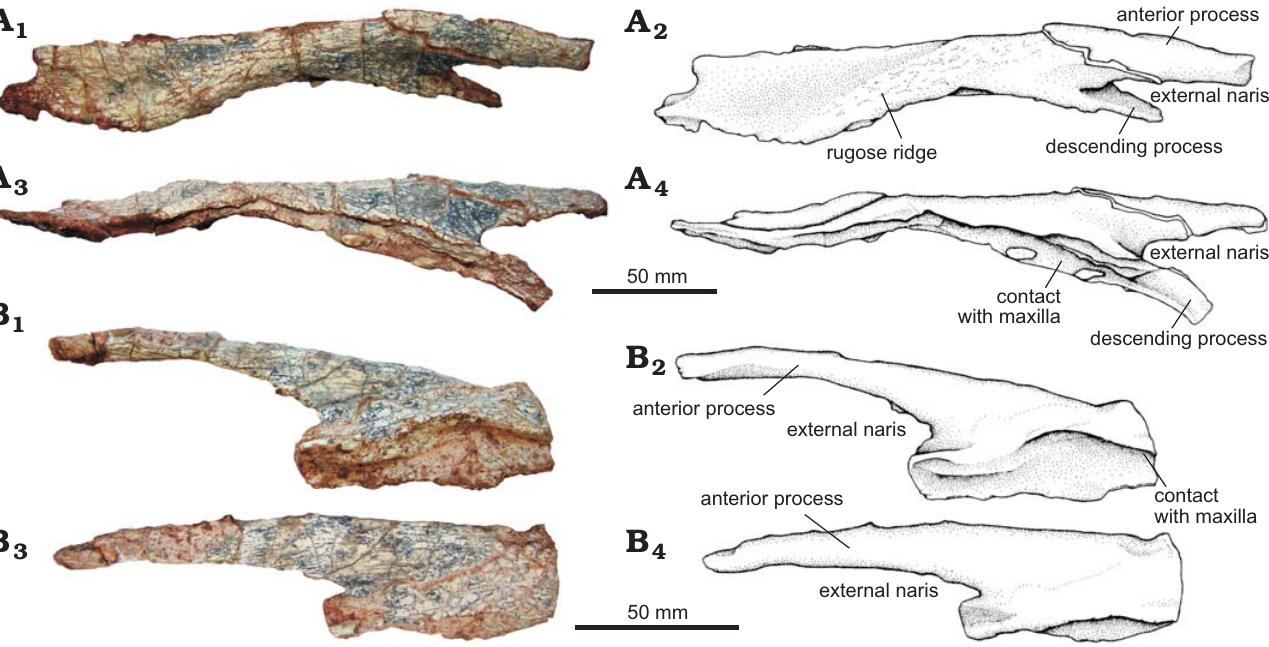
Fig. 7. The pseudosuchian archosaur Prestosuchus chiniquensis Huene, 1938 (UFRGS-PV-0629-T) from the Dinodontosaurus Assemblage Zone, Ladinian, Middle Triassic, Dona Francisca municipality, Rio Grande do Sul State, Brazil. A . Right nasal in dorsal (A 1 , A 2 ) and lateral (A 3 , A 4 ) views. B . Left nasal in lateral (B 1 , B 2 ) and dorsal (B 3 , B 4 ) views. Photographs (A 1 , A 3 , B 1 , B 3 ) and explanatory drawings (A 2 , A 4 , B 2 , B 4